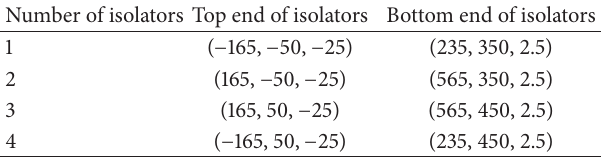
Table 2: Position coordinates of the resilient isolators (mm). Number of isolators Top end of isolators Bottom end of isolators